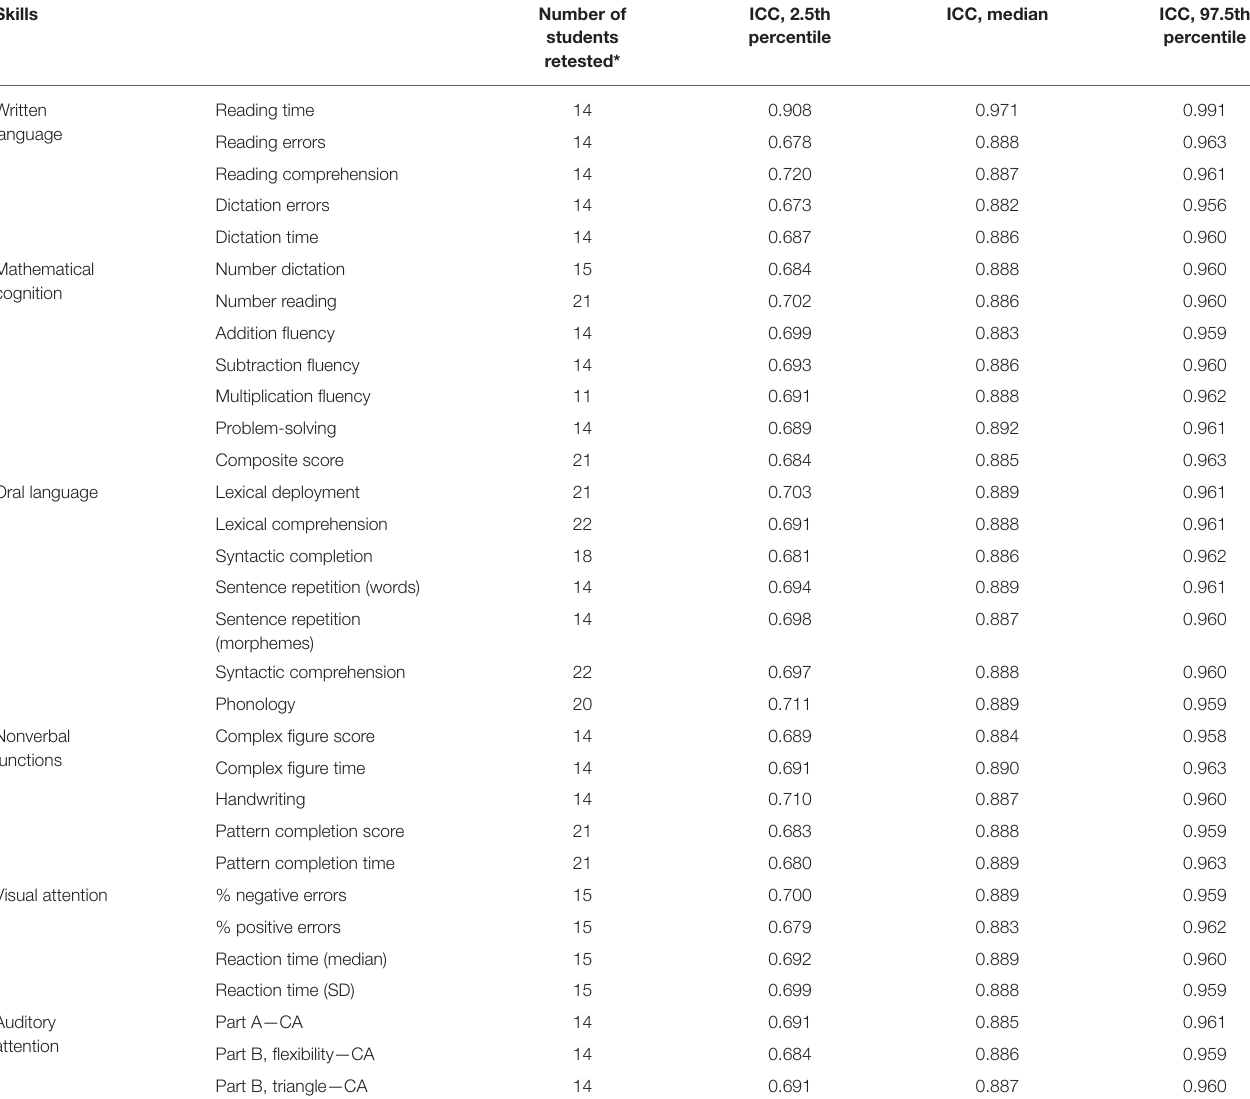
TABLE 4 | BMT- i test–retest reliability measured by intraclass correlation coefficients.